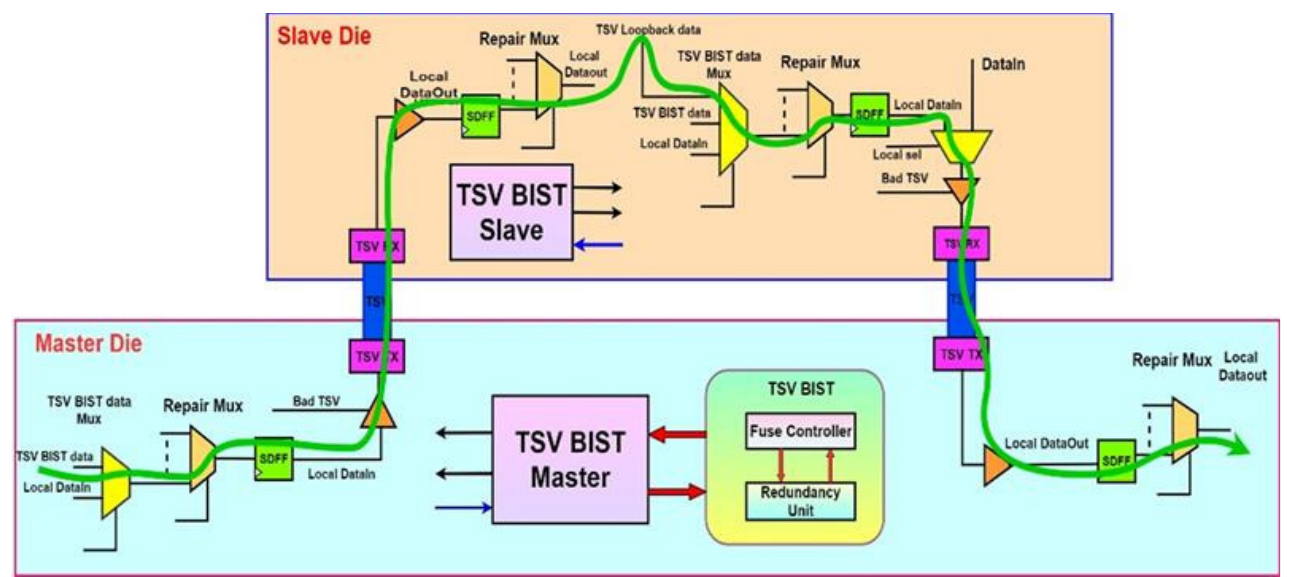
Figure 6. Write Group data path in TSV BIST Repair flow for 3D ICs (Reprinted with permission from ref. [21]. Copyright 2022 Springer Nature)